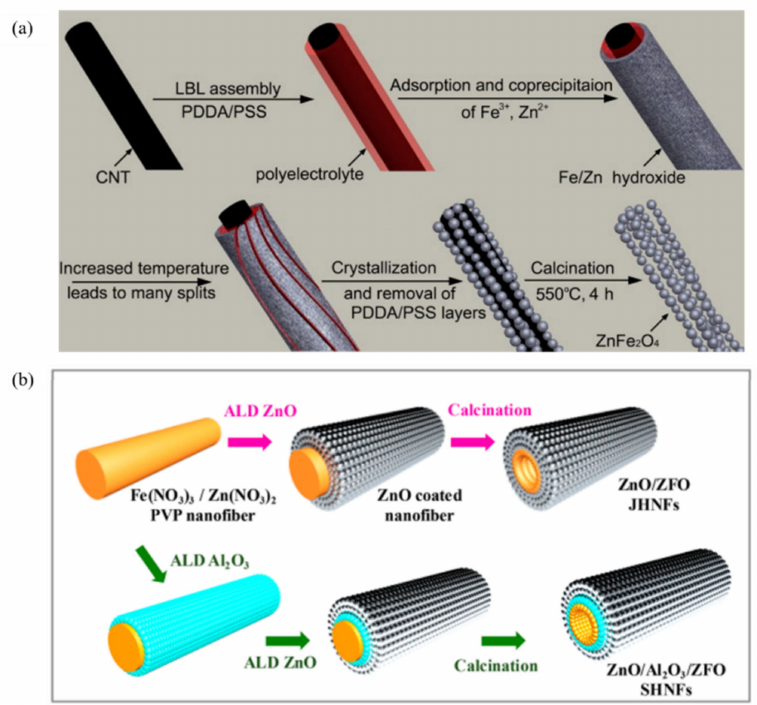
Figure 15. ( a ) A schematic representation of the synthesis process of ZnFe 2 O 4 nanochains [116] (reprinted with permission from [116] Zhang et al., 2010). ( b ) A schematic representation of the syn- thesis process of the ZnFe 2 O 4 nanochains [113] (reprinted with permission from [113] Liu et al.,